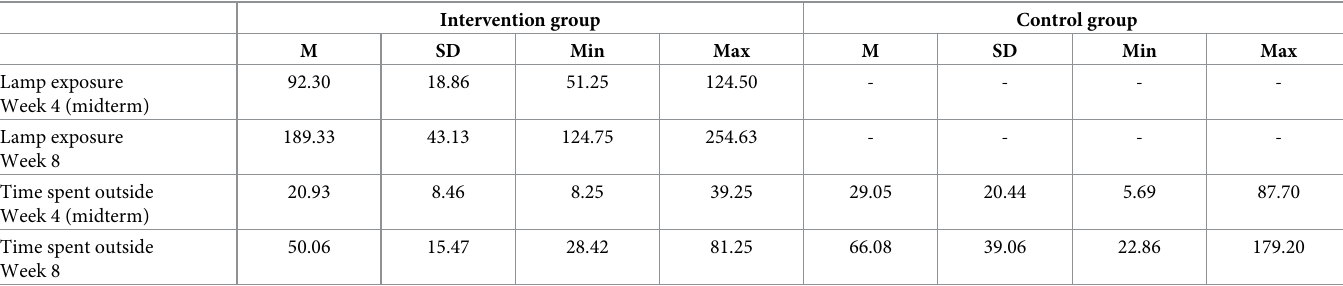
Table 4. Cumulative exposure time and time spent outside in hours over the study period.